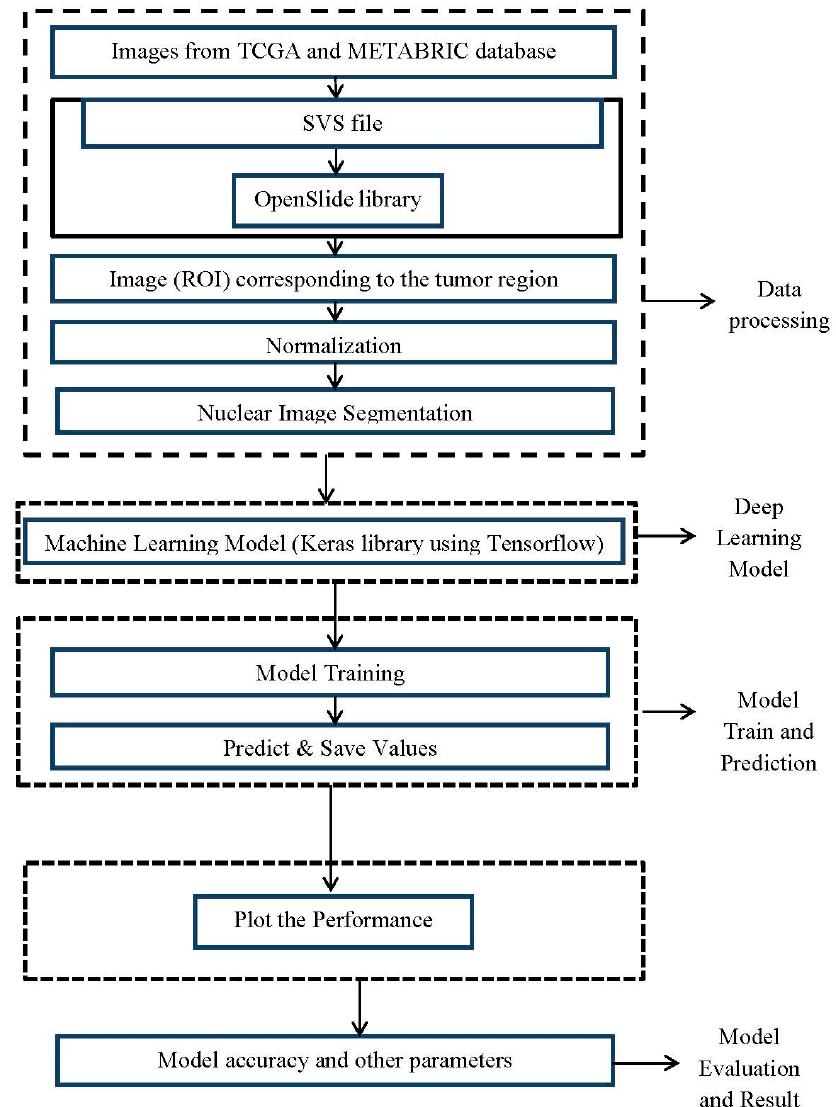
Figure 3. Block diagram of the proposed methodology .